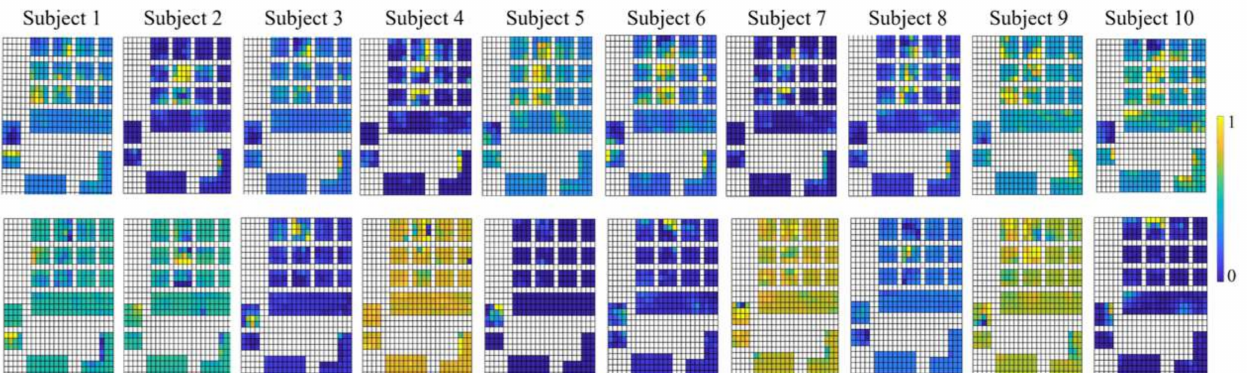
Figure 7. The first two dynamical synergies derived from averaged force vectors (for object weight 620 g) from all ten subjects. The first two dynamical synergies share the most common load force areas and are consistent across the subjects. The middle finger (in Synergy 1) and thumb (in Synergy 2) are the most used as captured by these two synergies. The other common load force areas are the index finger and palm.